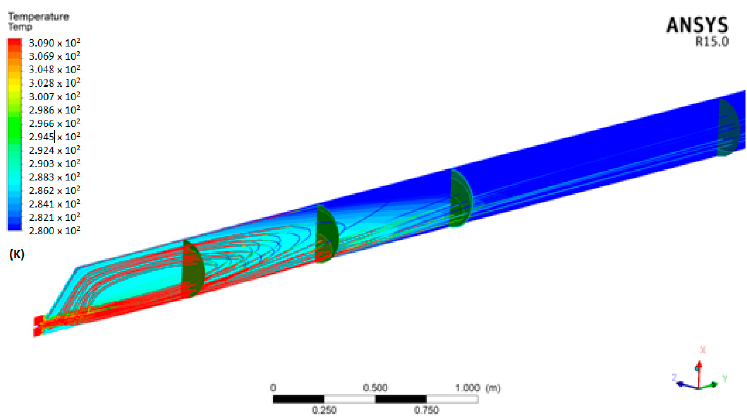
Figure 3. Temperature distribution in the median section of the pipeline and flow pattern-case 4, Table 3.